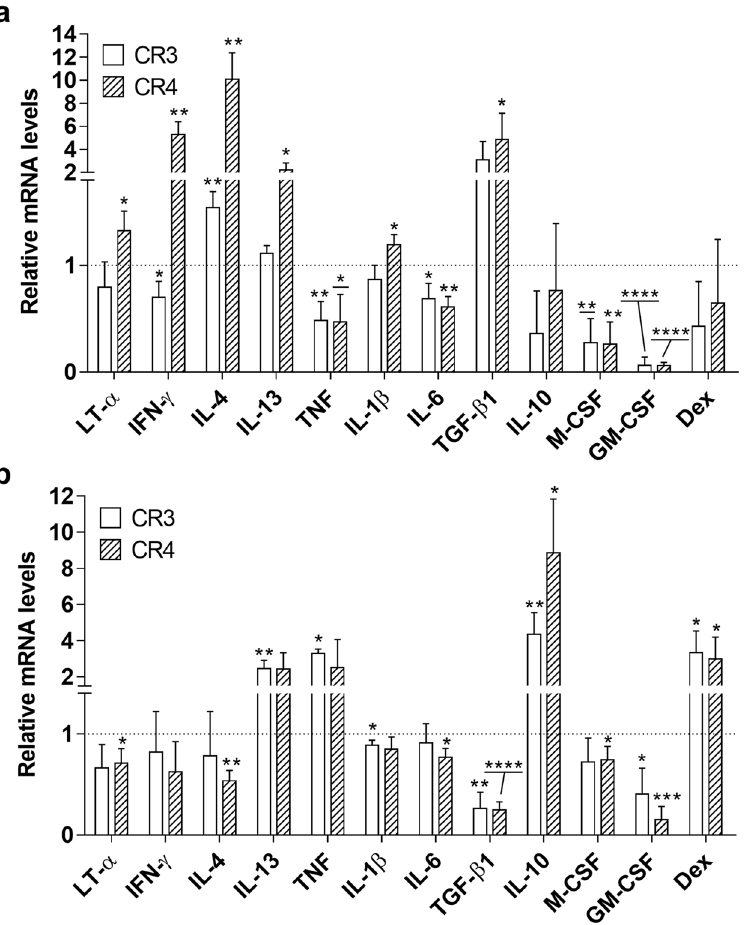
Figure 7. The effect of cytokines on the development of CR3 + and CR4 + macrophages and in MDM. ( a ) Monocytes were treated with 40 ng/ml LT- α , IFN- γ , IL-4, IL-13, IL-1 β , IL-6, IL-10, M-CSF, GM-CSF or dexamethasone, 20 ng/ml TNF, 15 ng/ml TGF- β 1. ( b ) Monocytes were cultured for 3 days for maturation into macrophages. The MDM were then incubated for 24 h with 40 ng/ml of the cytokines, LT- α , IFN- γ , IL-4, IL-1 β , IL-6, IL-10, IL-13, M-CSF, GM-CSF, 20 ng/ml TNF, 15 ng/ml TGF- β 1 or Dexamethasone (50 ng/ml). The level of CD11b and CD11c mRNA was measured using qPCR. Data are expressed as fold-change over GAPDH- normalized CD11b and CD11c mRNA in the absence of cytokine set as 1. Data are presented as means ± SD of three experiments, each conducted with cells from different individuals, * p < 0.05, * p < 0.05, ** p < 0.01, *** p < 0.001, **** p <